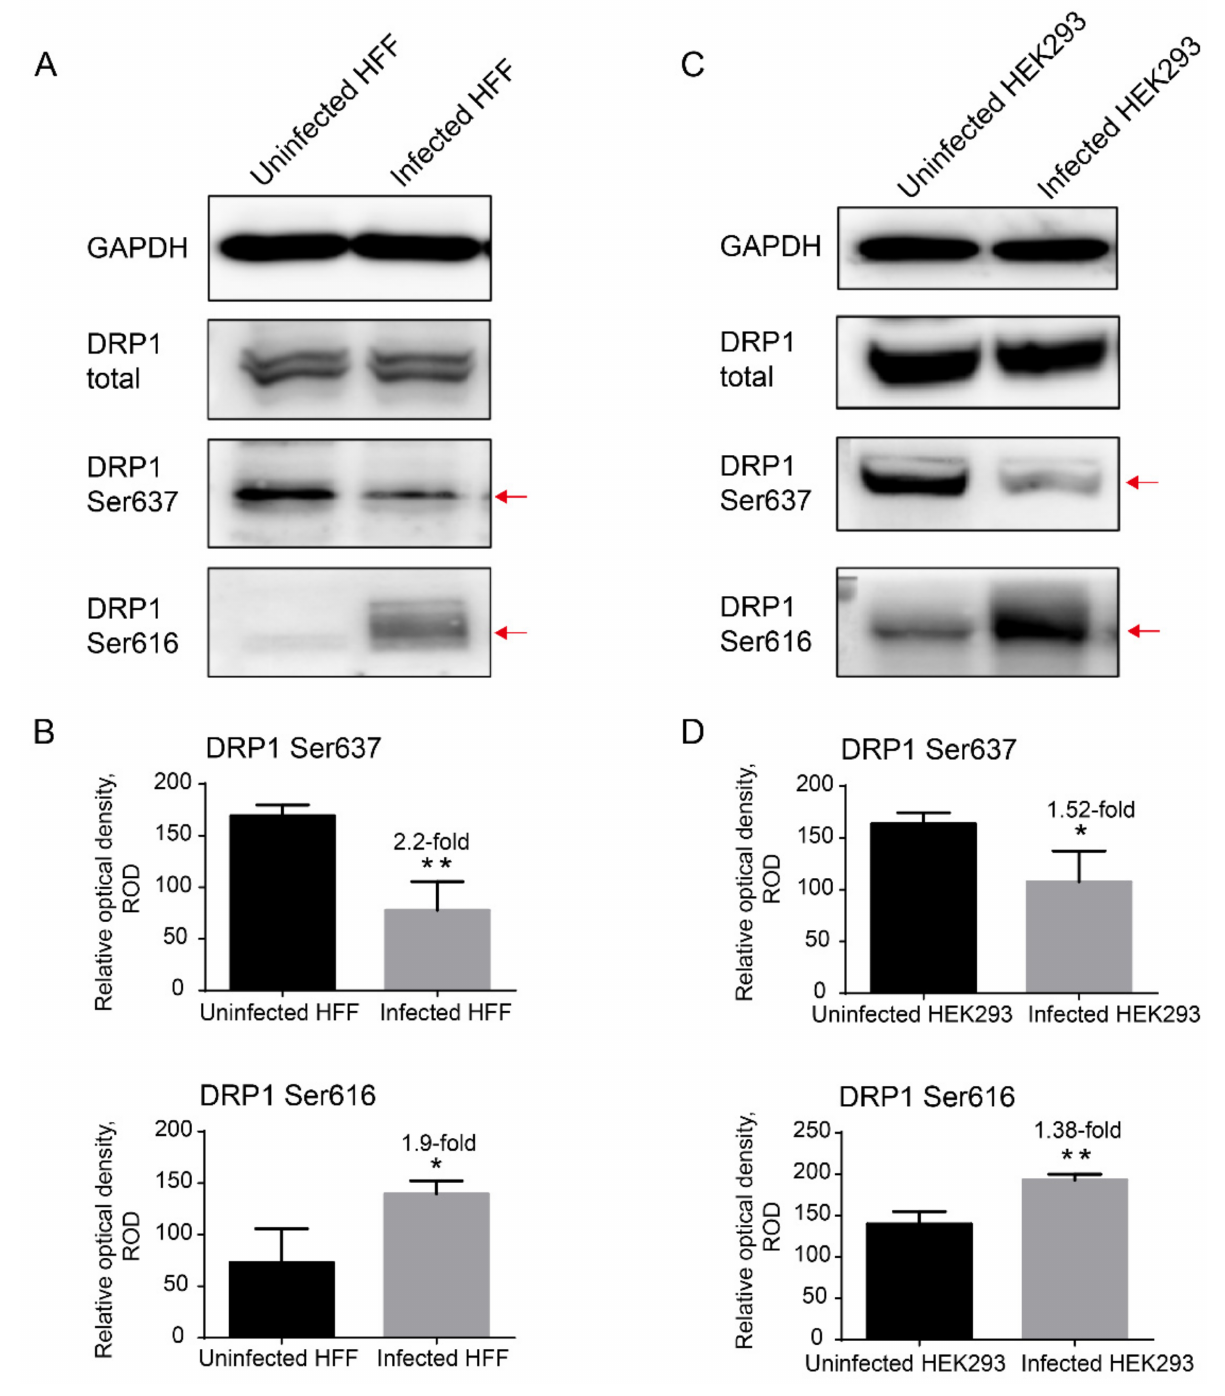
Figure 6. The regulation of DRP1 phosphorylation by E. hellem . ( A , C ) Western blot analysis of phosphorylation of DRP1 Ser637 and Ser616 in HFF cells (( A ) the second replicate shown in Figure S4) and HEK293 cells (( C ) the second replicate shown in Figure S4) 48 h post-infection by E. hellem , respectively. The GAPDH was used as an internal control. Red arrows indicate the significant changes in DRP1 phosphorylation. ( B , D ) Determination and statistical analysis of the relative optical density of DRP1 Ser637 and Ser616 calculated from the replicates of Western blot shown in Figure S4. * p < 0.05; ** p <